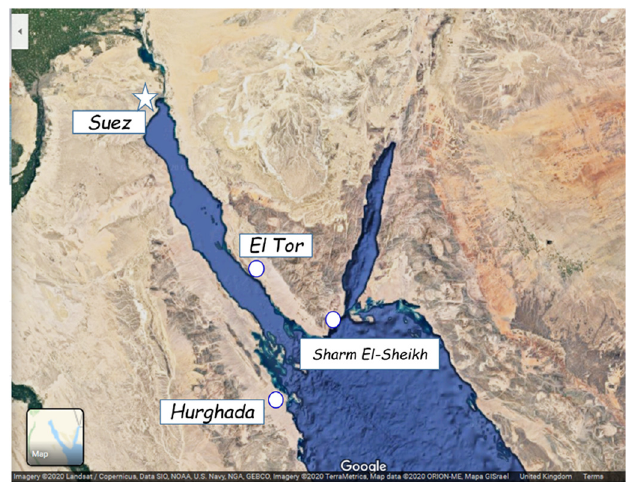
Fig. 1. Map for Suez city location in the Red Sea (white star) and some of the ley Red Sea cities from where Suez City market receive its landings. Photo credits GoogleMaps TM (details below the